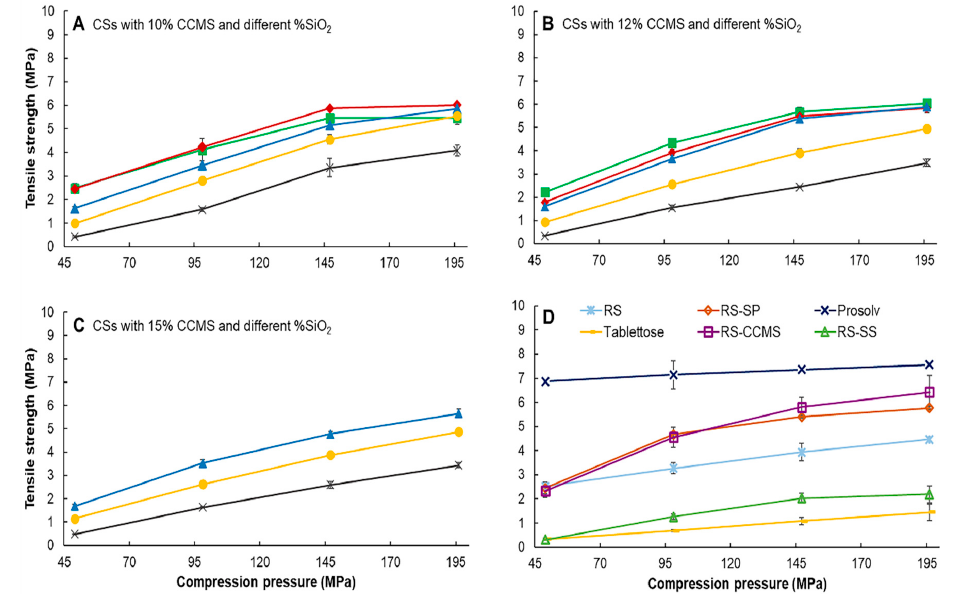
Figure 7. Tablet tensile strength of CSs with different CCMS and SiO 2 levels . ( A ) CSs with 10% CCMS, ( B ) CSs with 12% CCMS, ( C ) CSs with 15% CCMS . and ( D ) control samples . SiO 2 levels were represented as ( ■ ) 0.5%, ( ♦ ) 1.0%, ( ▲ ) 2.7%, ( ● ) 4.05%, and (x) 6.75%.